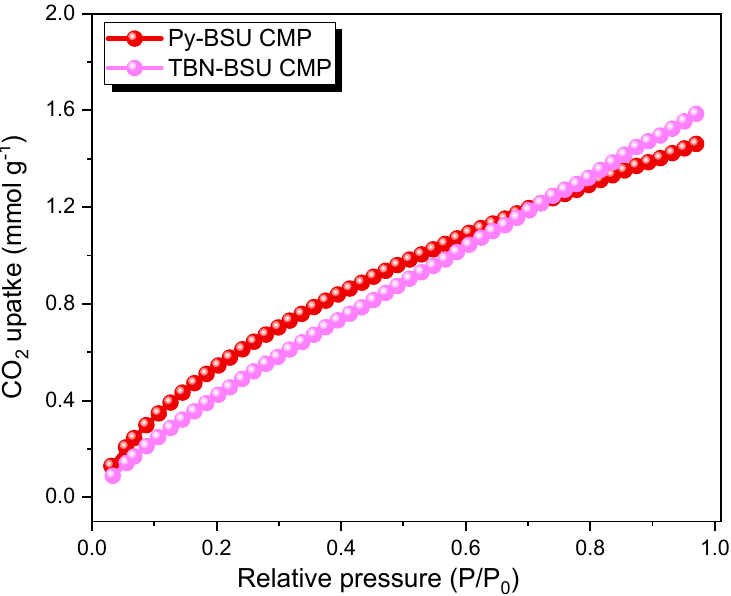
Figure 4. CO 2 uptake of Py-BSU CMP and TBN-BSU CMP was recorded at 298 K.